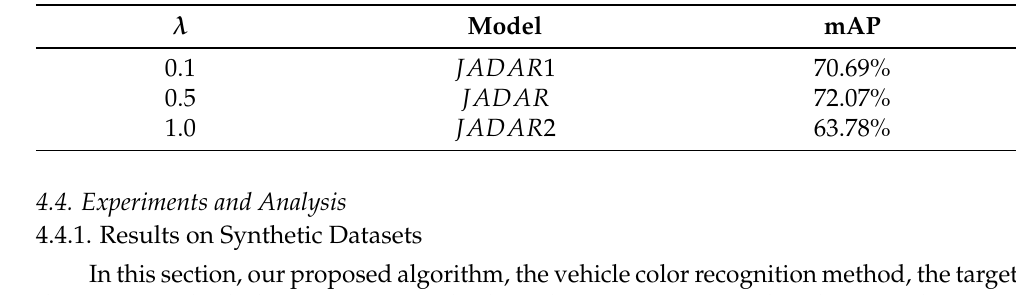
Table 1. The mAPs using different values for the loss function coefficient λ of the deraining module in JADAR on the RVC -24 test set.